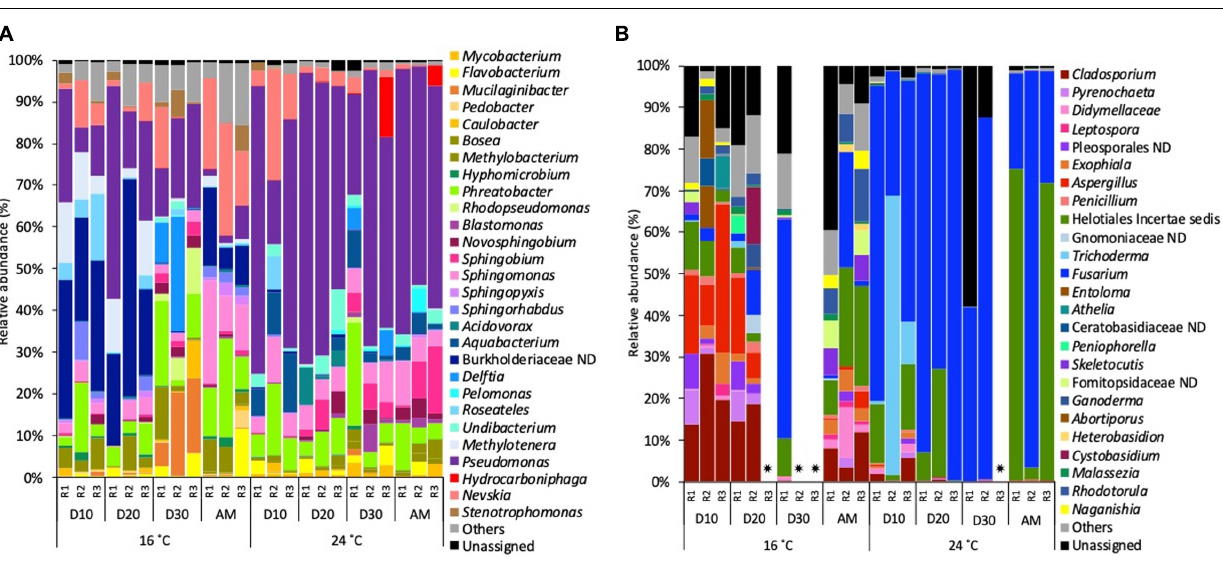
FIGURE 5 | Relative abundance of (A) bacterial genera and (B) fungal genera ( > 1% of the total sequences) at 16 and 24 ◦ C in biofilm samples every 10 days (D) throughout the growth phase and after the mobilisation phase (AM). The 3 replicates (R1, R2, and R3) per sampling point are represented. Remaining genera were combined in category “Others.” Category “Unassigned” correspond to unidentified OTUs and “ND” means not defined at that level. ✷ Samples that did not amplify during the sequencing